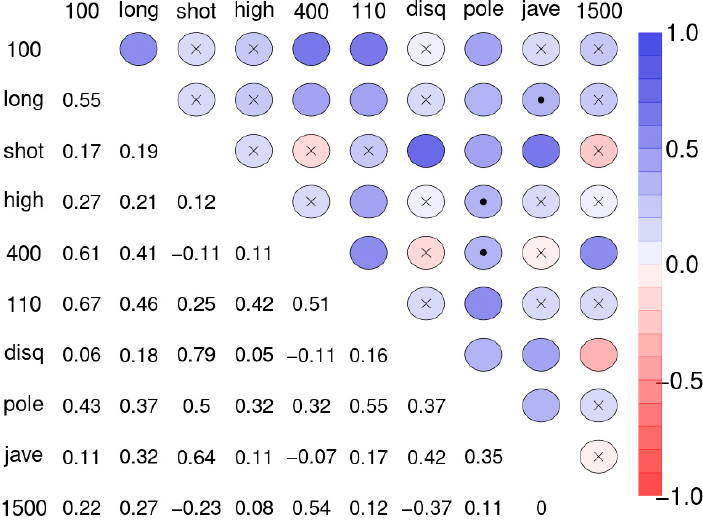
Figure 2. Spearman correlation matrix for pairwise correlations between the disciplines of the decathletes. Upper diagonal: blue color circles indicate positive, red colors indicate negative correlations. Insignificant correlations ( p > 0.1) are indicated by “x”, weakly significant correlation ( p > 0.05 and ≤ 0.1) by dot. Lower diagonal: coefficients of correlation (r). Abbreviations used: 100-m sprint (100), long jump (long), shot put (shot), high jump (high), 400-m run (400), 110-m hurdle race (110), discus throw (disq), pole vault (pole), javelin throw (jave), and 1500-m run (1500).